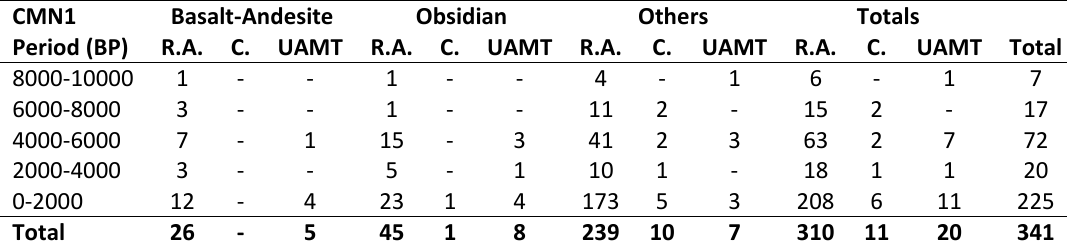
Table 2. Cueva Milodon Norte 1 (CMN1) lithic assemblages by period. RA: Retouched artefact; C: core; UAMT: Unretouched artefact with marginal traces. CMN1 Basalt-Andesite Obsidian Others Totals Period (BP) R.A. C. UAMT